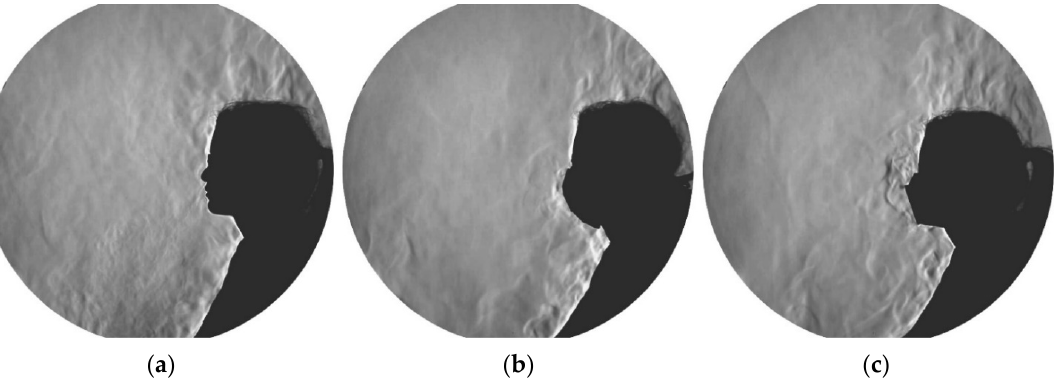
Figure 6. Schlieren images of a female test subject when wearing no mask ( a ), surgical mask ( b ), and FFP2 mask ( c ). The corresponding videos of these images are available in the Supplementary Materials (Videos S1, S2, and S3).